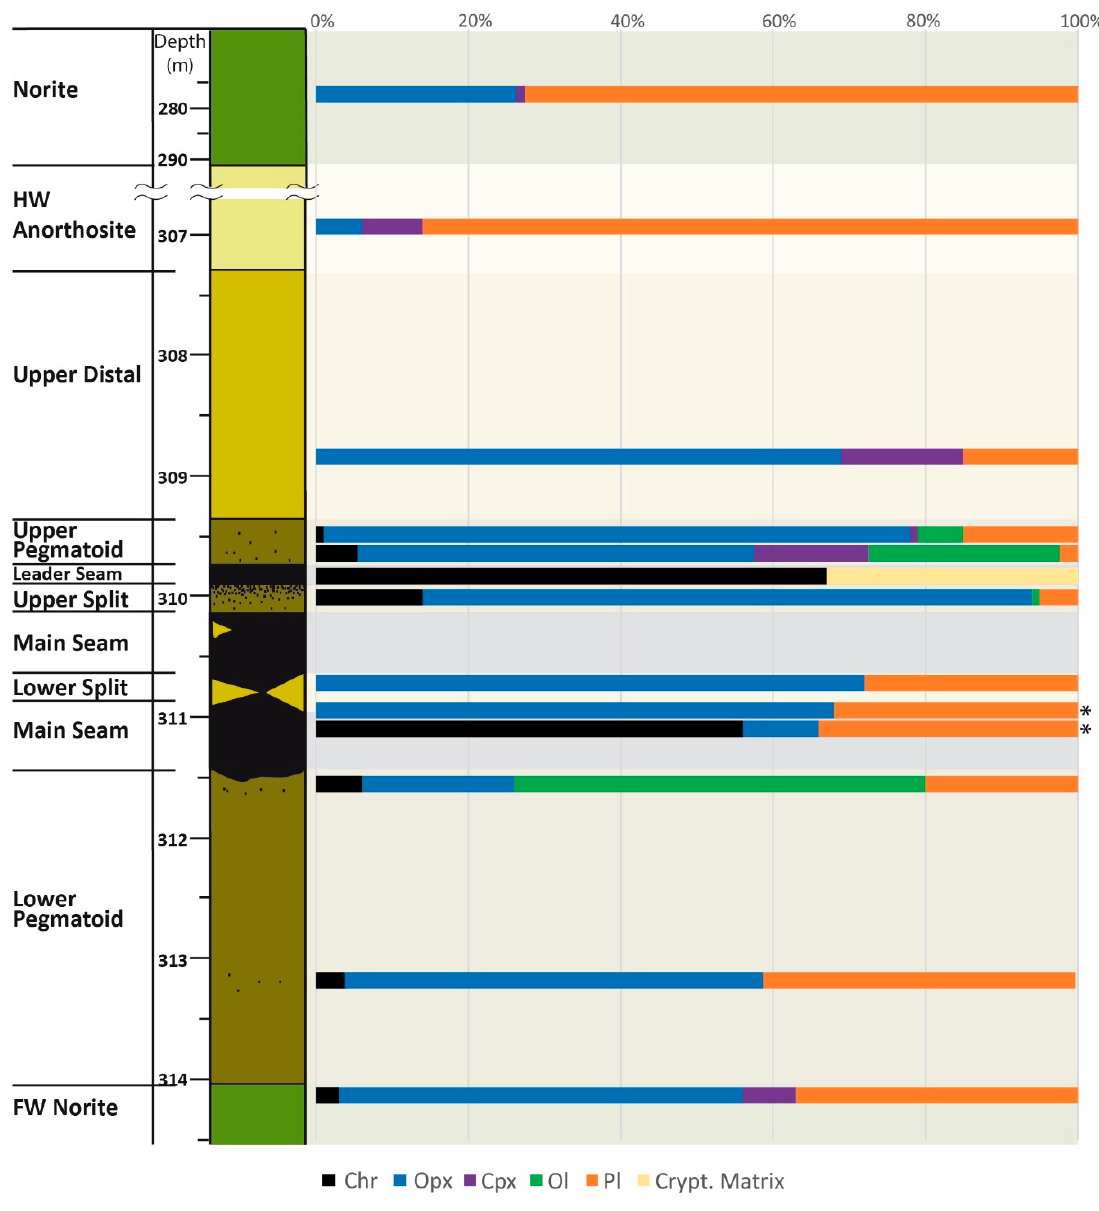
Figure 3. Modal abundance of primary mineral phases and cryptocrystalline matrix in the UG2 subunits, determined by point counting on thin section samples. For sample 310.90a, which contains the contact zone of the Main Seam and the Lower Split (Figure 4C), the mode was determined for each of the two subunits individually (marked by two asterisks). Chromite (Chr), orthopyroxene (Opx), clinopyroxene (Cpx), olivine (Ol), plagioclase (Pl), cryptocrystalline matrix (Crypt. Matrix).